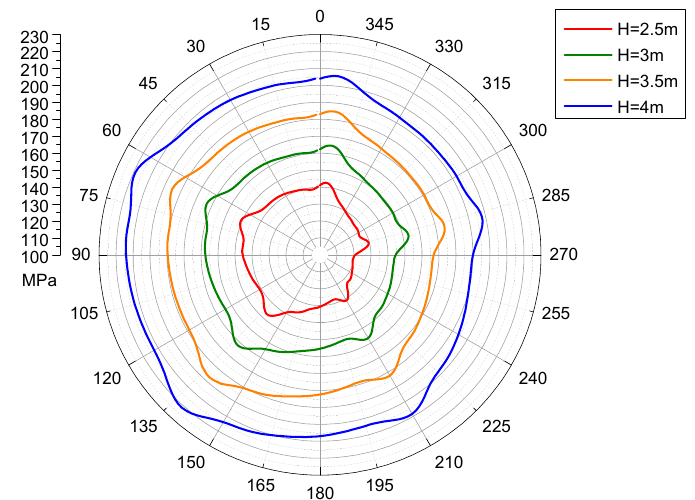
Figure 9. Maximum dynamic stress change rules of blades under different heads.